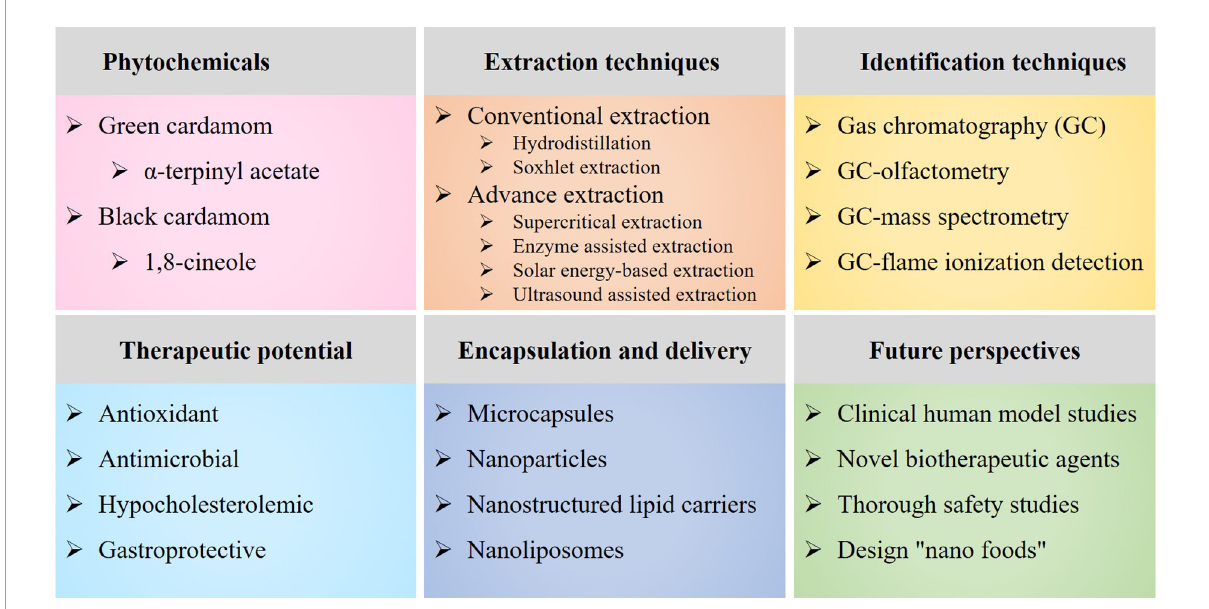
FIGURE1 An overview diagram elaborating the main cardamom phytochemicals, extraction techniques, identification techniques, therapeutic potential, encapsulation and delivery, and future perspectives.